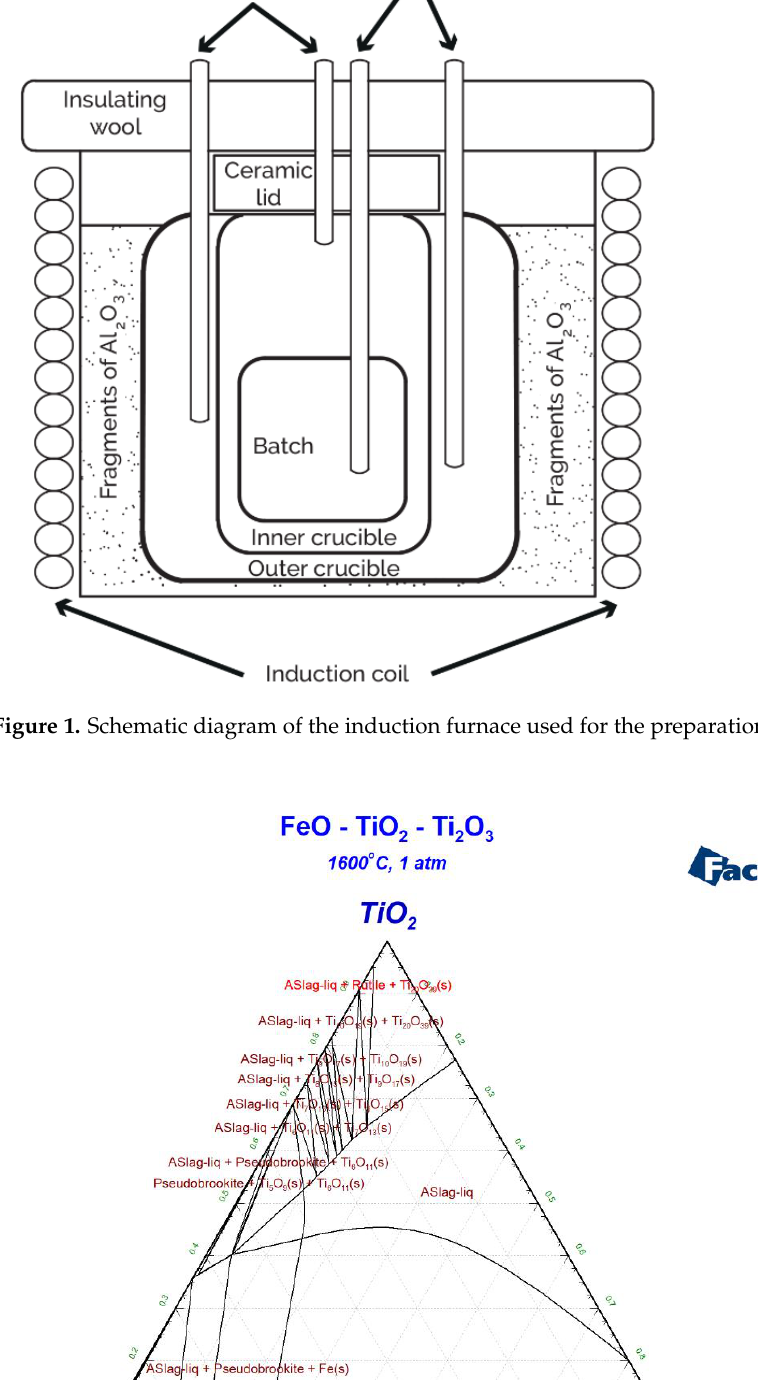
Table 1. Sample weight of components (in grams) and the liquidus temperature for each test. Weight in Grams Sample